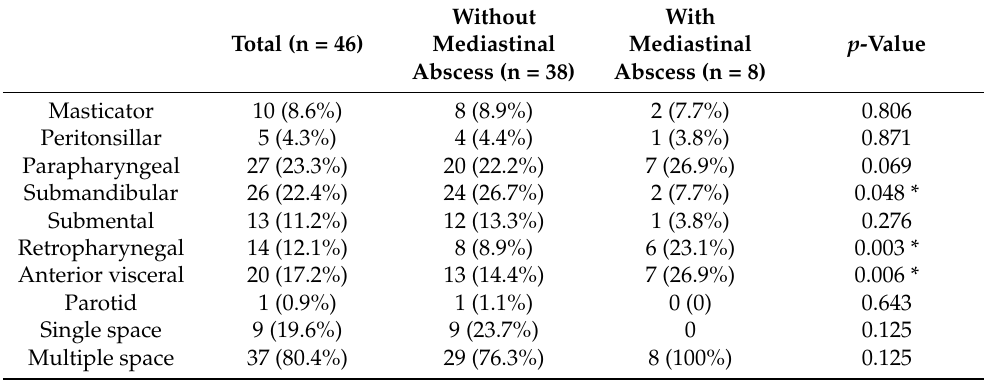
Table 2. Comparison of involved spaces in patients with and without mediastinal abscess.